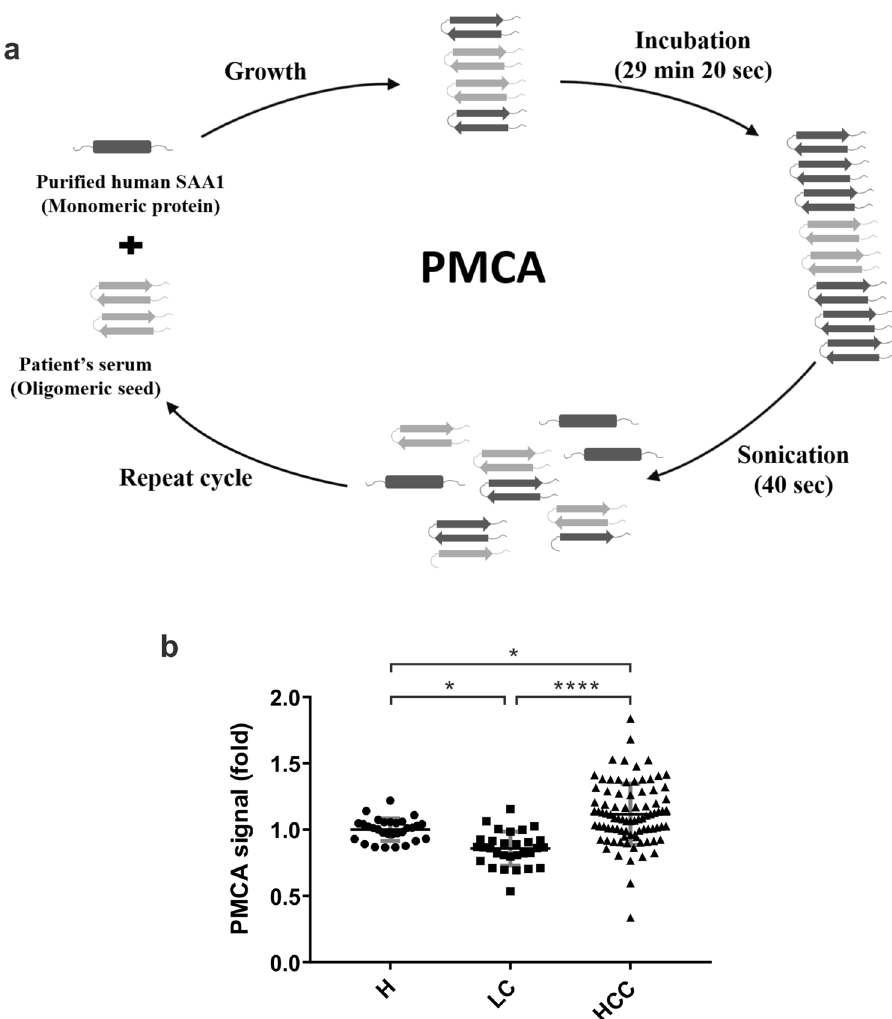
Figure 2. Comparison of PMCA signals among hepatitis, LC, and HCC patients. ( a ) Diagram illustrating the principle of PMCA technique. A standard PMCA procedure starts with incubation of oligomeric seeds with monomeric amyloid protein to allow growth of the polymers. The aggregates are then fragmented by sonication to increase the number of seeds for further aggregate growth. After repeating PMCA cycles, the concentration of initial preformed oligomeric protein can be amplified and thus easy to be detected. ( b ) Comparison of PMCA signals among hepatitis, LC, and HCC patients. A total of 146 serum samples from 30 hepatitis (indicated as H), 30 LC, and 86 HCC patients were measured and analyzed. The statistical analysis was performed by one-way ANOVA and Tukey’s Post Hoc Test, where P < 0.05 (*) and < 0.0001 (****). NS not